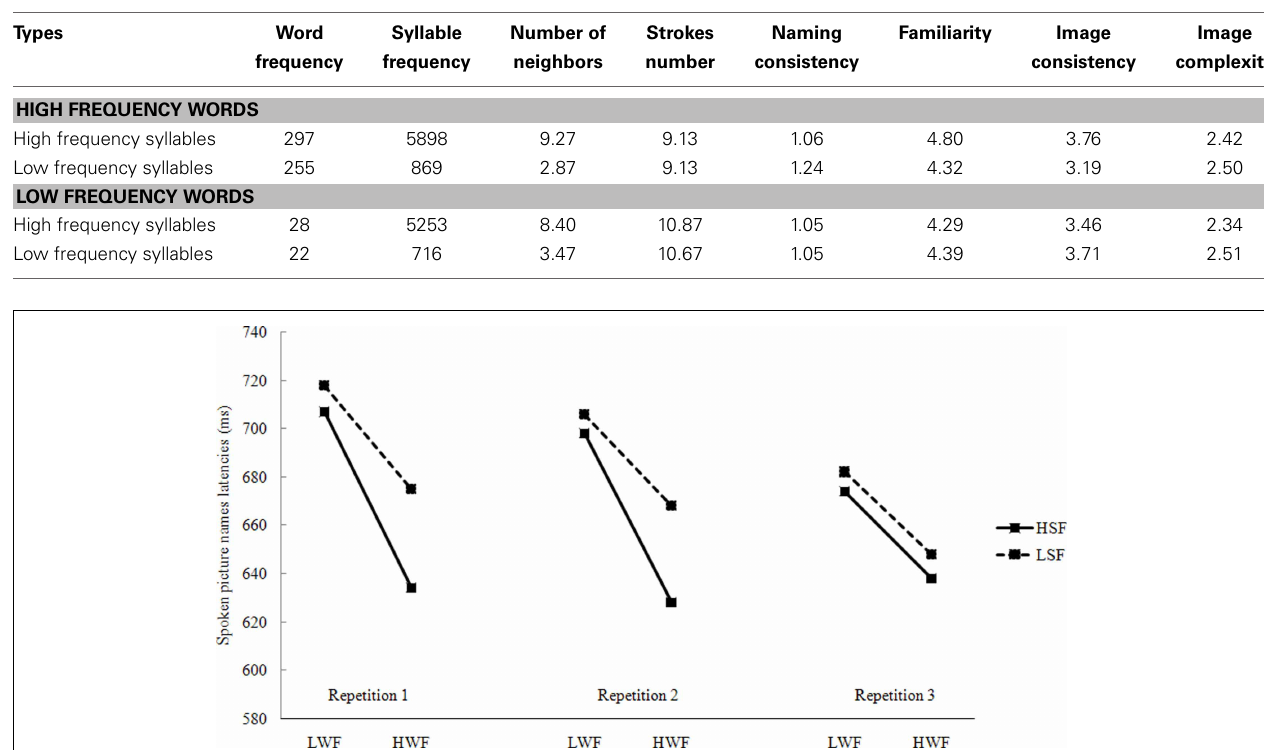
Table 1 | Means word frequency (per million), syllable frequency (per million), number of neighbors, strokes number, naming consistency, familiarity, image consistency, and image complexity of the stimuli.